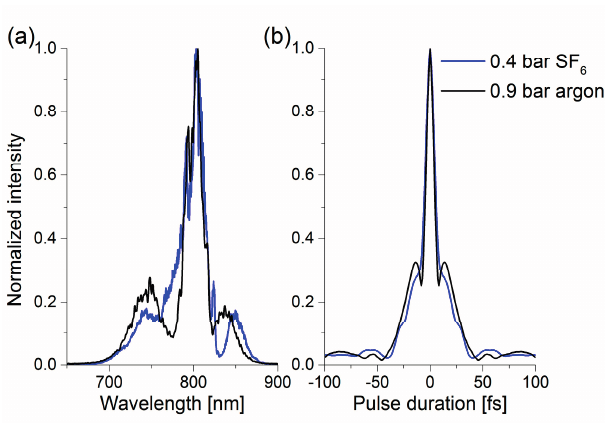
Figure 4. Spectrally broadened laser pulses after propagation through the hollow-core fiber ( a ) and their corresponding Fourier transform assuming a flat spectral phase ( b ) are compared for argon (black line) and SF 6 (blue